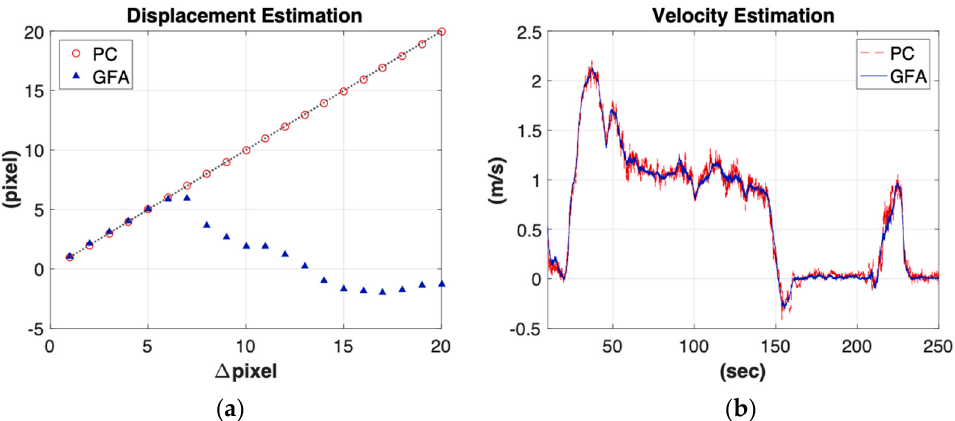
Figure 9. Motion estimation using two vision algorithms: ( a ) For the displacement estimation, the GFA (blue triangle) can detect the shift within 6 pixels whereas the PC method (red circle) can detect the shift up to 20 pixels. ( b ) For the velocity estimation, the results from the PC method (red line) were much noisier than from the GFA optical flow (blue line).